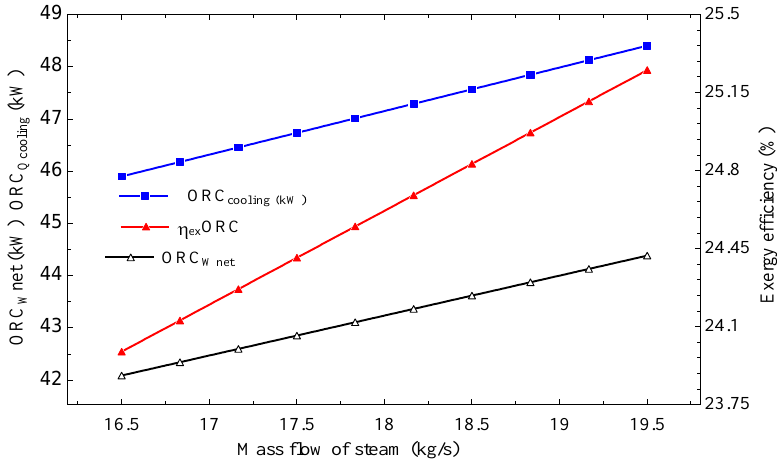
Figure 3. E ff ect of mass flow rate of steam on exergy e ffi ciency, network, and cooling load of the Figure 3. Effect of mass flow rate of steam on exergy efficiency, network, and cooling load of the ORC ORC system.